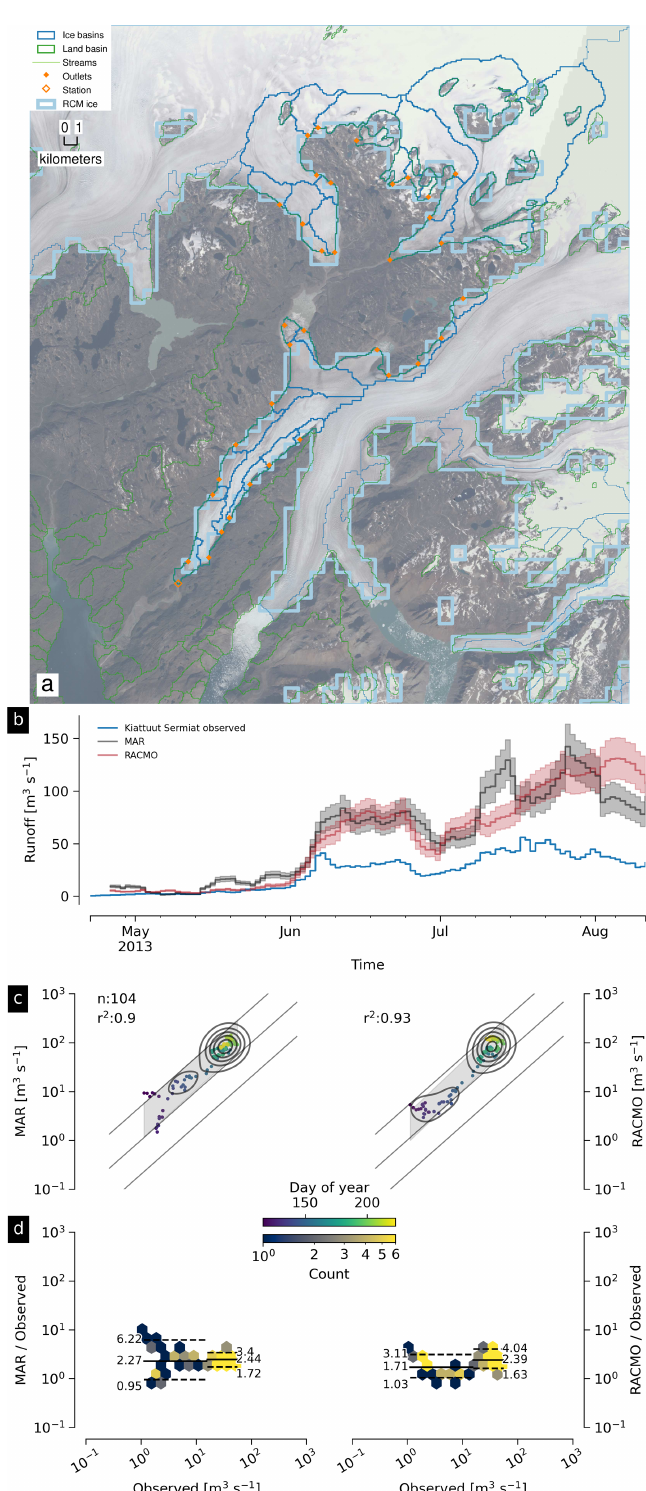
Figure 10. Graphical summary of Kiattuut Sermiat outlet, basin, and discharge (Ks in Fig. 1). See Sect. 3.4 for a general overview of graphical elements and Sect. 4.2.4 for discussion of the Kiattuut Sermiat basin. Basemap from Howat et al. (2014) and Howat